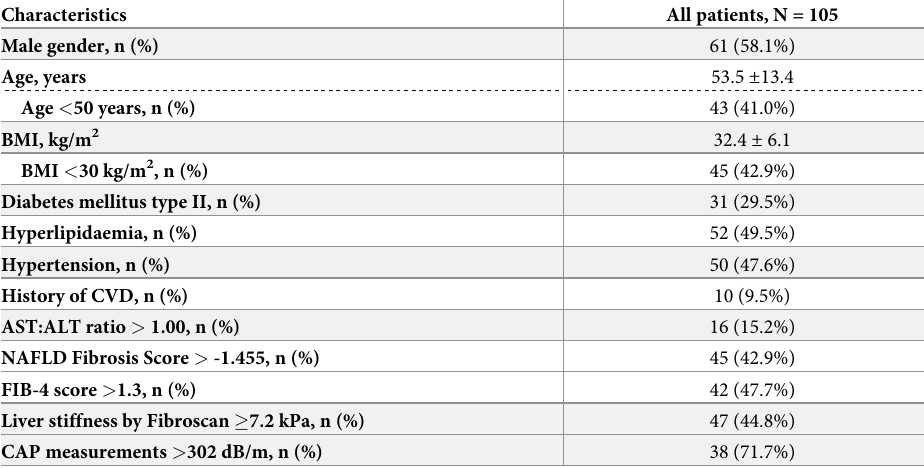
Table 1. Demographic and clinical characteristics of all study